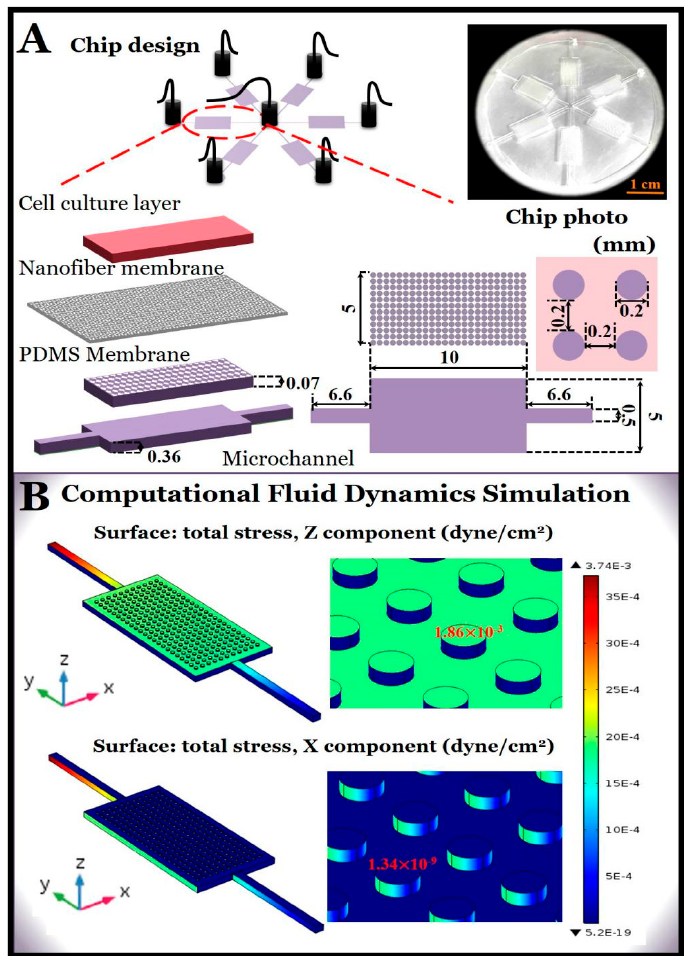
Figure 2. ( A ) Structure and size of multi-layered lung chips. The inset shows a photograph of the chip. The shot is taken from the angle of the microchannel layer and shows the microchannel of the chip and the white poly (lactic-co-glycolic acid) (PLGA) fiber membrane; ( B ) the results of computational fluid dynamics simulation. The shear stresses in the Z and X components were located on the surface of the composite membrane in the perfusion